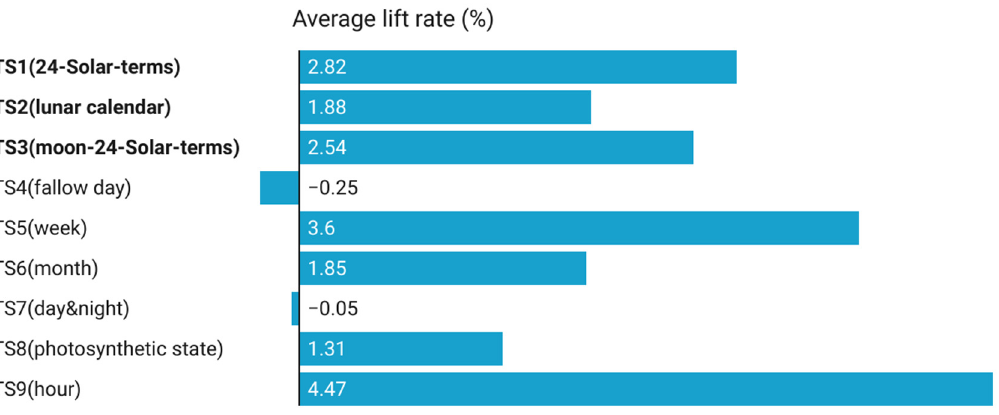
Figure 10. Average increase in the R 2 of the model (time series features).